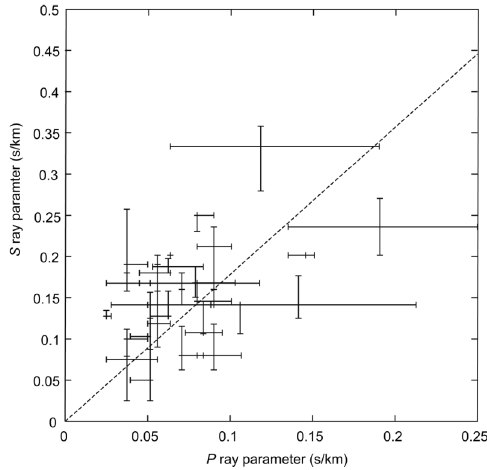
Fig. 12. Comparison of the ray parameters derived from slowness analyses of P - and S -waves.